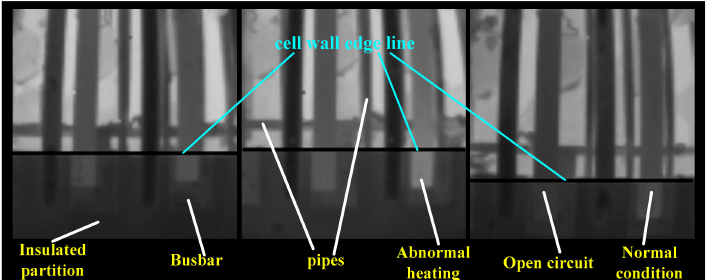
Figure 6. The approximate vertical position of the cell wall edge in different conductive states.